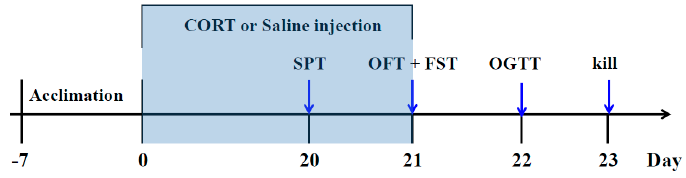
Figure 8. Schedule of the experiment.